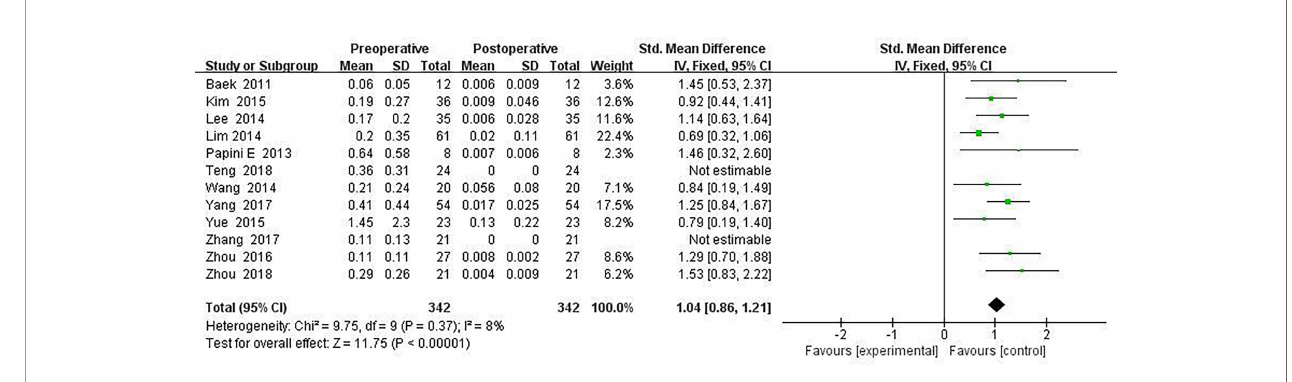
FIGURE 2 | Forest plots of volume changes before and after